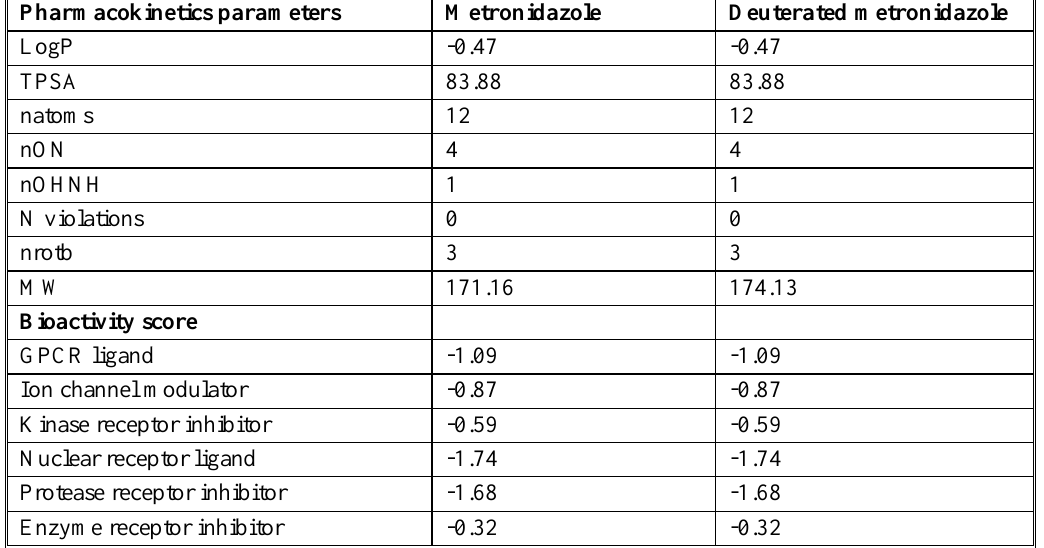
Table 1. In silico studies for metronidazole and its deuterated